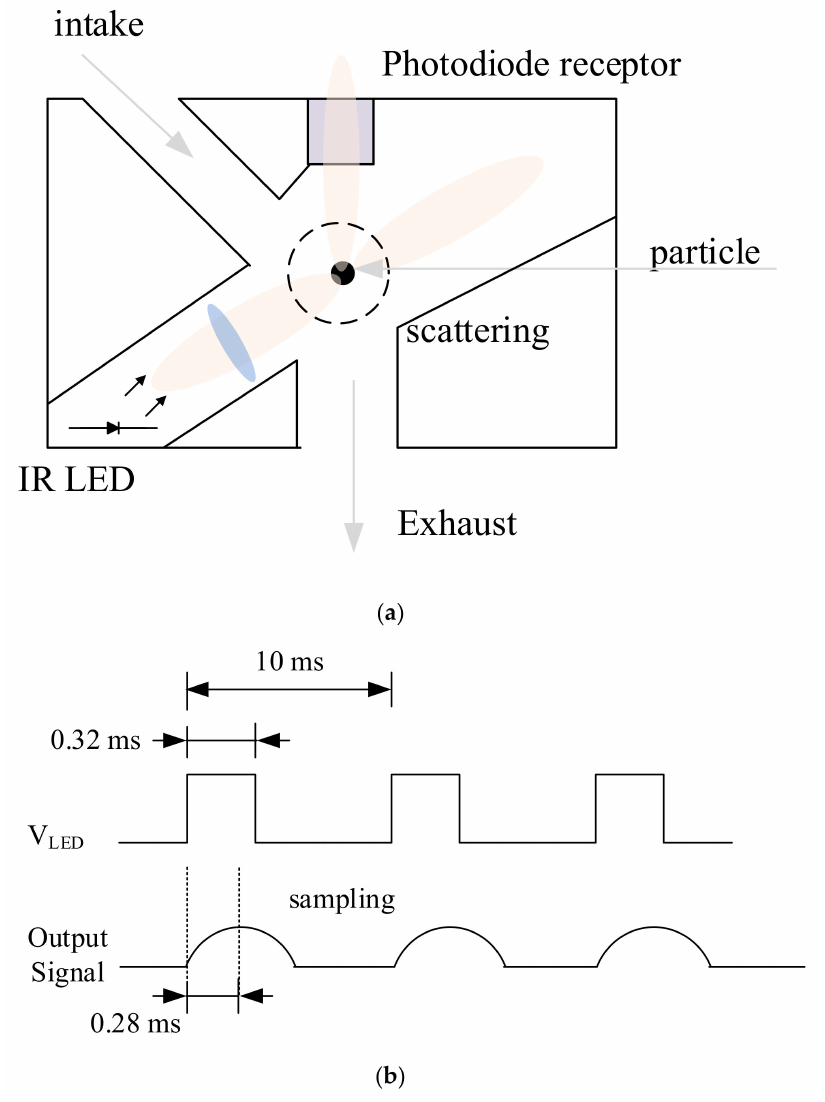
Figure 2. Output signal of the PM sensor: ( a ) operation principle and ( b ) input/output